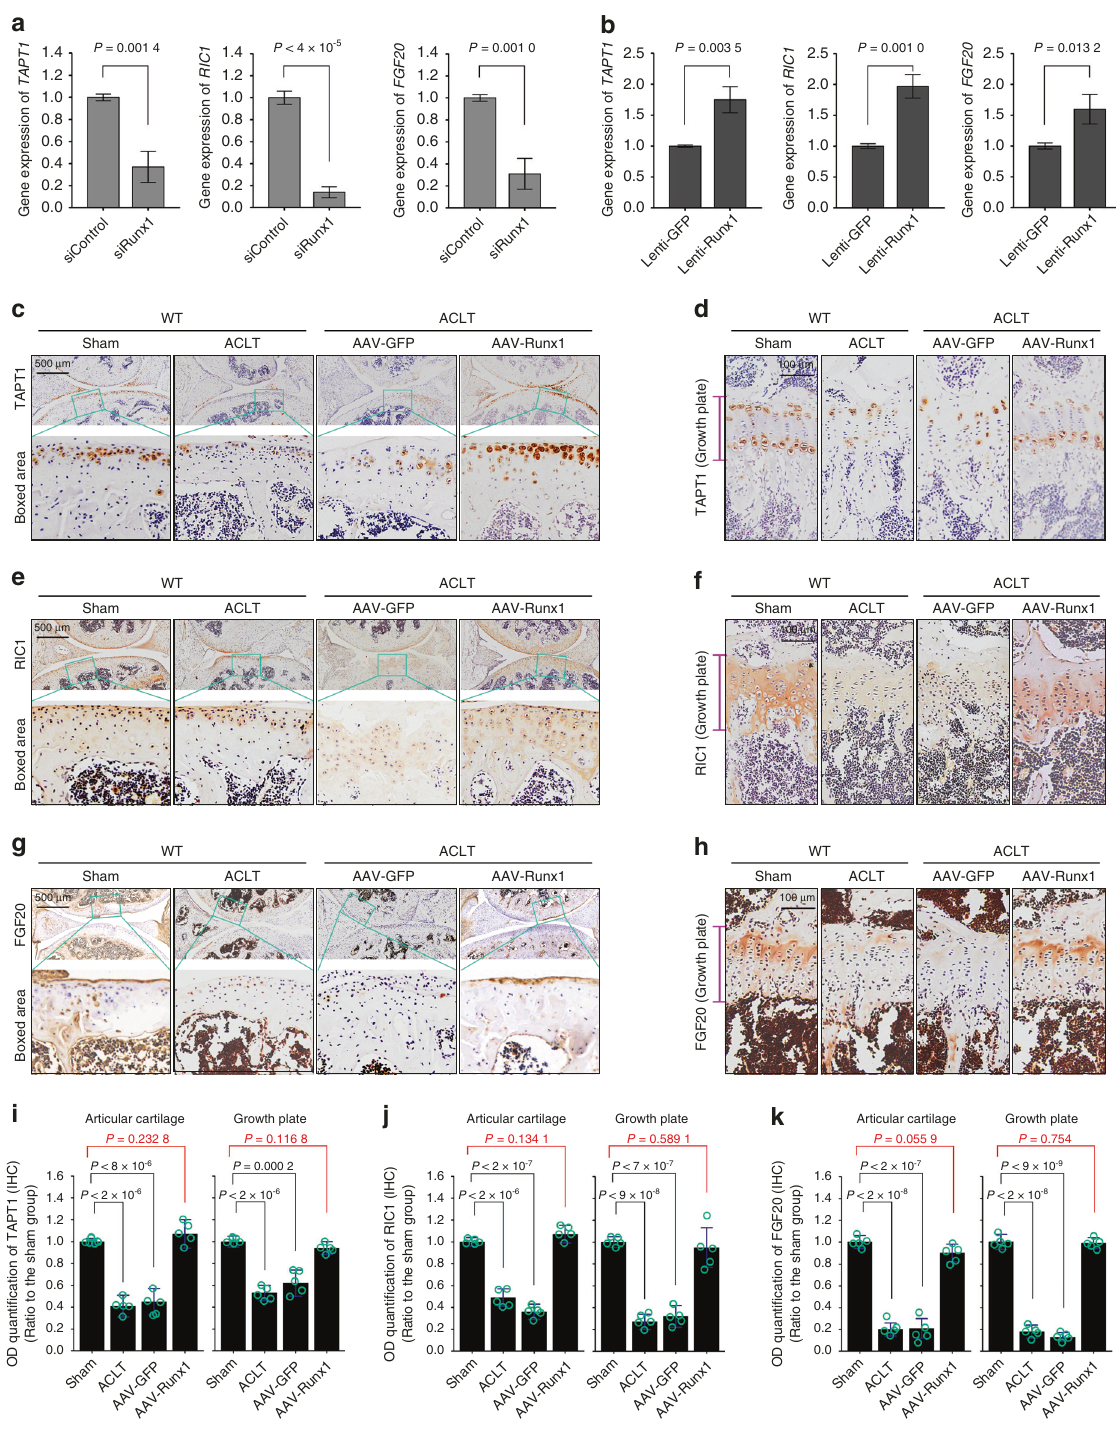
Fig. 7 The expression of target candidates in cartilage. a qPCR results showing changes in TAPT1 , RIC1 , and FGF20 in chondrocytes induced by siRunx1. b qPCR results showing changes in TAPT1 , RIC1 , and FGF20 in chondrocytes induced by Runx1 overexpression. c , d IHC staining showing AAV-Runx1 overexpression-induced changes in TAPT1 expression in articular cartilage at 12 weeks after ACLT surgery ( a ) and the growth plate at 24 weeks after ACLT surgery ( b ). e – f IHC staining showing AAV-Runx1 overexpression-induced changes in RIC1 expression in articular cartilage at 12 weeks after ACLT surgery ( a ) and the growth plate at 24 weeks after ACLT surgery ( b ). g – h IHC staining showing AAV-Runx1 overexpression-induced changes in FGF20 expression in articular cartilage at 12 weeks after ACLT surgery ( a ) and the growth plate at 24 weeks after ACLT surgery ( b ). i Optical density quantitative analysis showing changes in TAPT1 expression in articular cartilage and the growth plate. j Optical density quantitative analysis showing changes in RIC1 expression in articular cartilage and the growth plate. k Optical density quantitative analysis showing changes in FGF20 expression in articular cartilage and the growth plate. These results are based on at least three independent experiments ( n = 3). All signi fi cance data presented in a , b , i , j , and k are based on two-tailed Student ’ s t